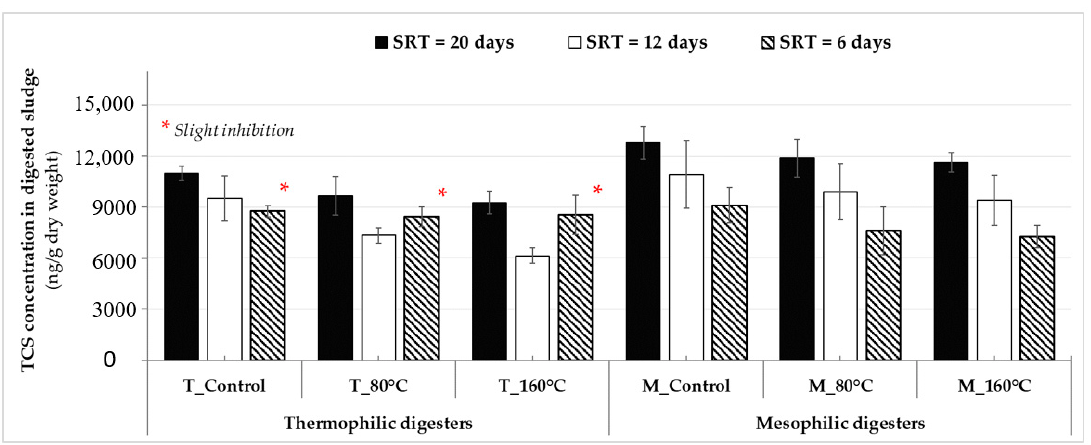
Figure 5. Average triclosan (TCS) concentrations in anaerobically digested sludge obtained from thermophilic and mesophilic digesters at sludge retention times (SRTs) of 20, 12, and 6 days during steady-state.